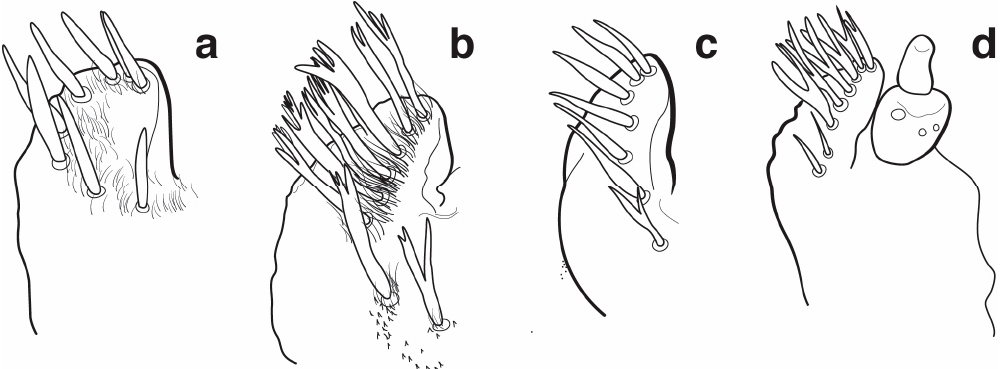
Figure 47. Mala and maxillary palp ( d only), larva, dorsal view: ( a ) Rhodobaenus ; ( b ) Temnoschoita ; ( c ) Myocalandra; and ( d ) Eucalandra .